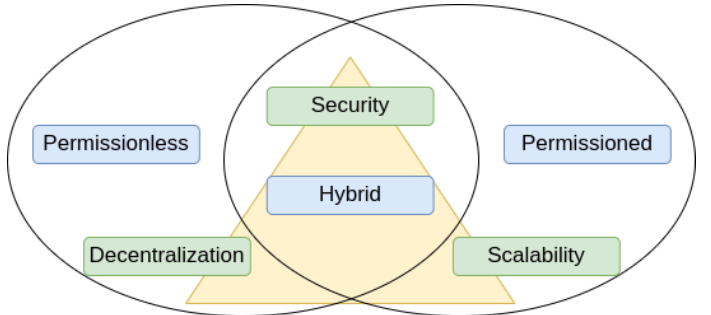
Figure 2. Blockchain trilemma with the permissioned and permissionless